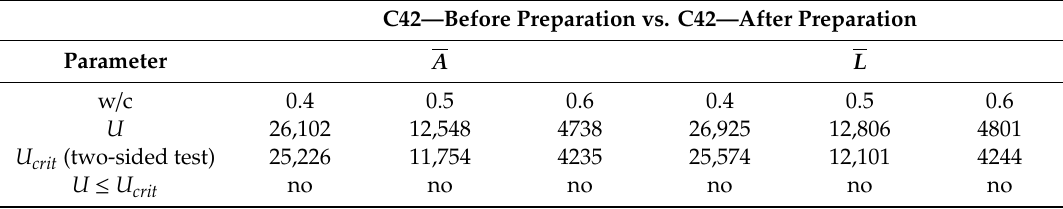
Table 3. The Mann-Whitney U test